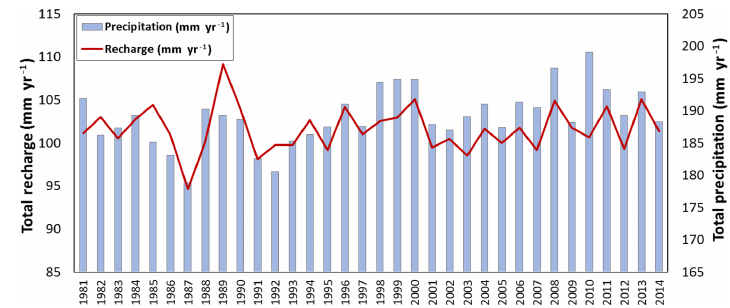
Figure 9. Temporal distribution of total global recharge along with total global precipitation of corresponding years for a period of 1981 to 2014.